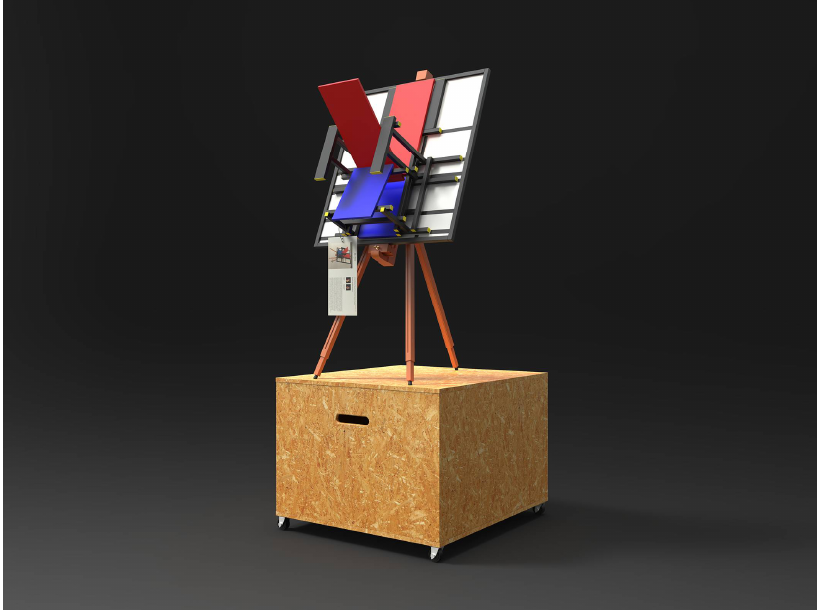
Figure 2. Michelangelo Lamonaca, Martina Carlini: “ Blob